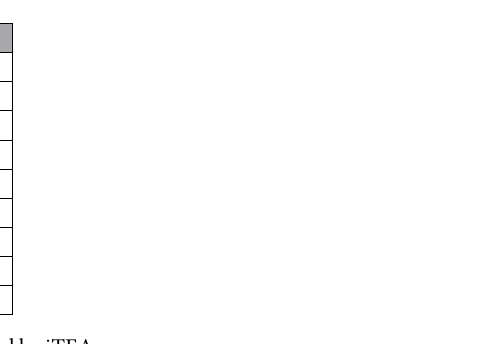
Table 2. Functional genetic variant candidates provided by